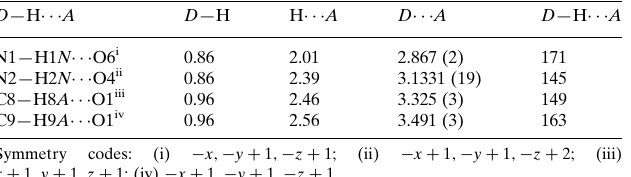
Hydrogen-bond geometry (A˚ , (cid:2)